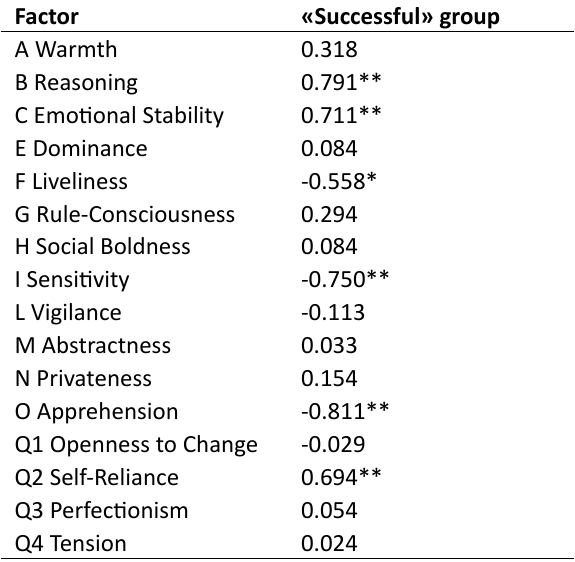
Table 2. Correlation coefficients between the final indicator of the success of sports activity and the factors of the personal questionnaire by R.